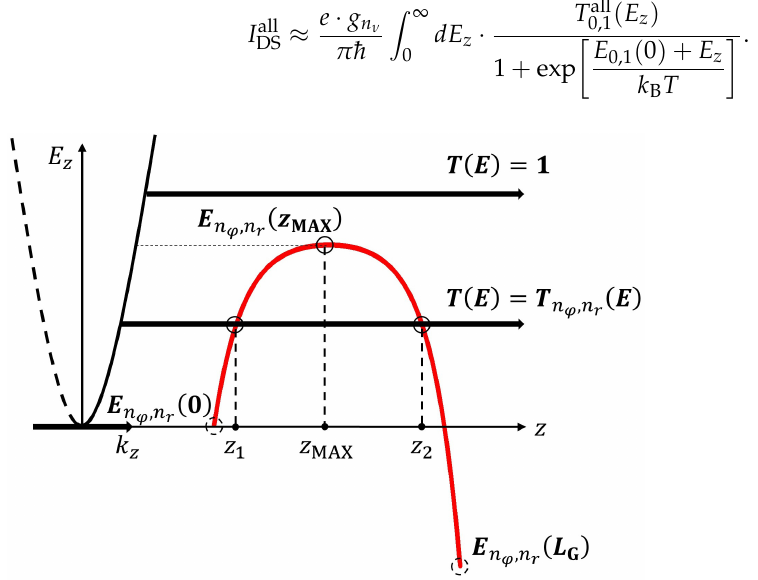
Figure 3. Schematic representation of electrons transported between the source and drain, correspond- ing to their total energy. Illustrations of the quantum tunneling and thermionic ballistic transport mechanism of electron transport across the potential barrier from the source to the drain along the ( z ) obtained from Equation (1) is represented. Turning points channel. Sub-band energy profile E n ϕ , n r ( z 1 and z 2 ) and z MAX are shown in literal values. Here, k z is the electron wave vector component in the z direction corresponding to the parabolic dispersion relation for E z . Schematic representation for the electrons transporting between the source and drain according to the total energy of electrons. Several possible cases for electron transport are